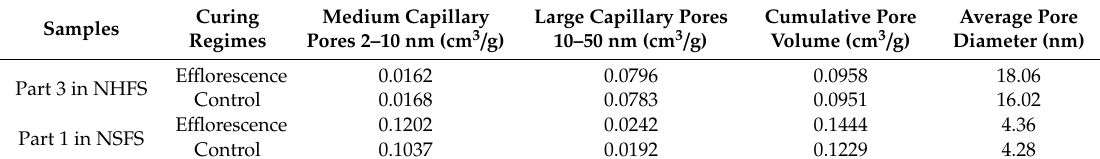
Table 2. Pore structure parameters of the control and exposed geopolymers.